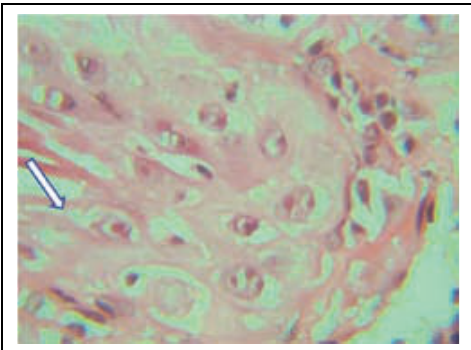
Fig 3. Pleomorphic population of epithelial cells showing feeble intercellular bridges, anisokaryosis, prominent nucleoli and a few mitotic figures. (H&E staining, 1000x